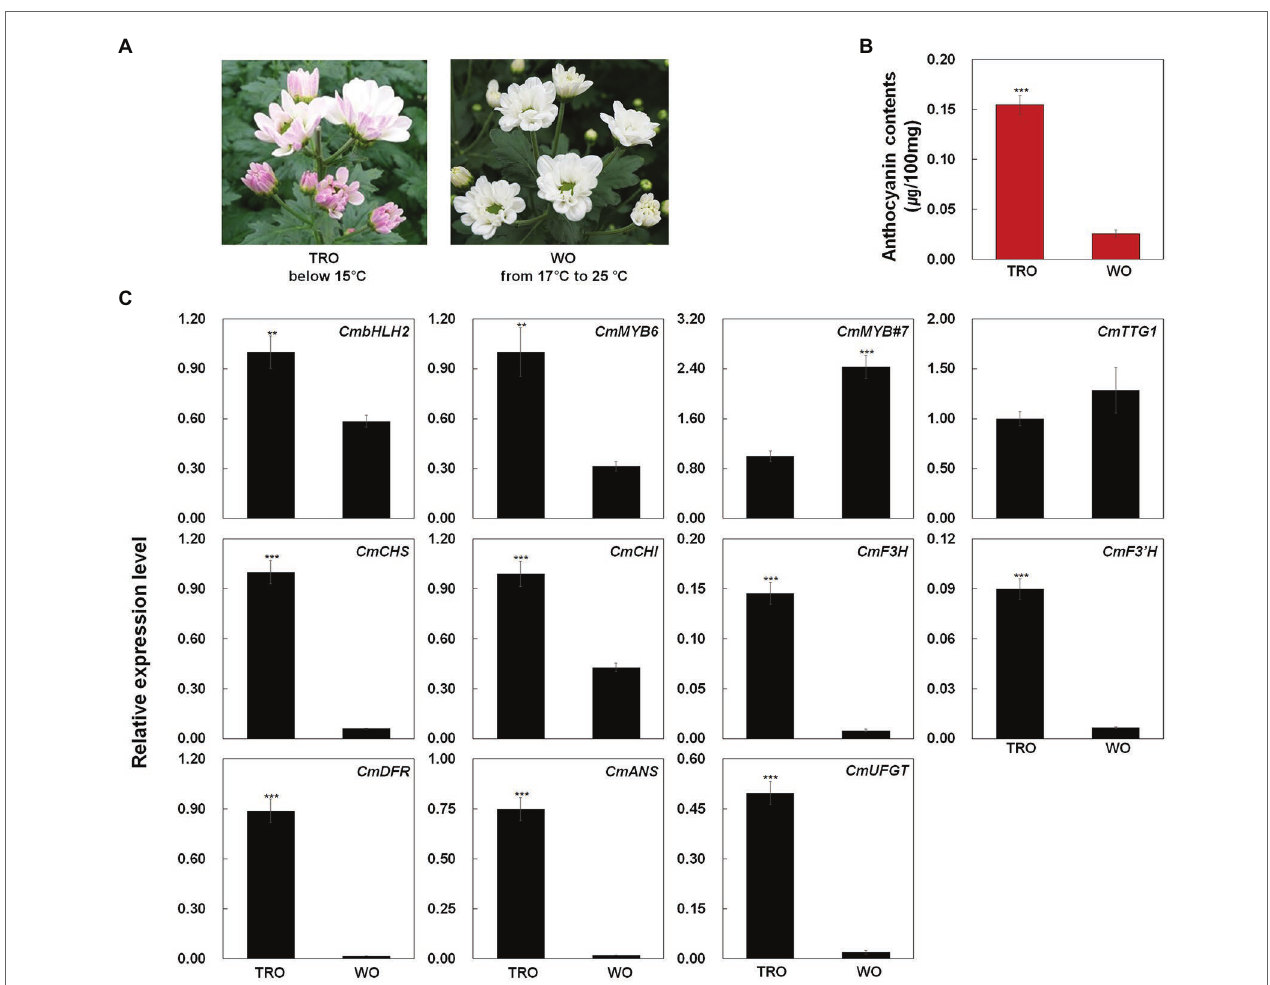
FIGURE 1 | Phenotypes, anthocyanin contents, and anthocyanin biosynthetic gene expression levels in turning red “OhBlang” (TRO) or white “OhBlang” (WO) ray florets. (A) Photographs of TRO and WO flowers at the full-bloom stage. (B) Anthocyanin level in TRO and WO ray florets. Error bars are the SE of three independent experiments. (C) Expression levels of anthocyanin biosynthetic genes and regulatory genes in TRO and WO ray florets. Results represent mean values ± SD from three biological replicates. CmEF1 α was used as the reference gene. ** and *** indicate values that differ significantly from the control at p < 0.01 and p < 0.001, respectively, according to Student’s paired t